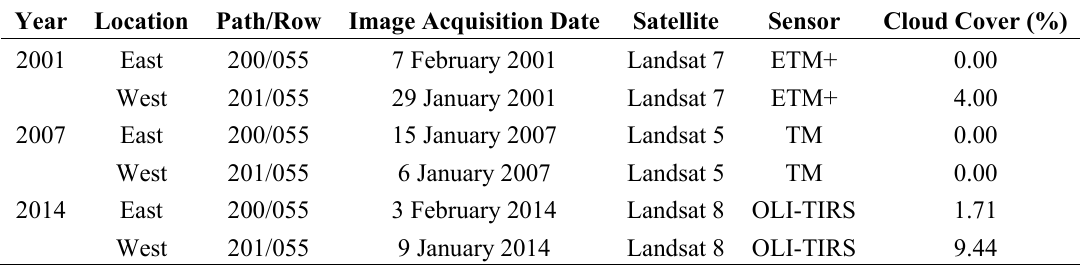
Figure A1. Intermediate products derived from each of CLASlite’s four built-in steps using the 2014 Landsat satellite image over the eastern portion of Gola as an example. ( A ) Band selection for representation of the raw Landsat image is R = Band 5 (0.85–0.88 μ m), G = Band 4 (0.64–0.67 μ m), and B = Band 3 (0.53–0.59 μ m). ( B ) Band selection for representation of the reflectance product is the same as that for (A). ( C ) Band selection for representation of the fractional cover product is R = bare substrate, G = photosynthetic vegetation, B = non-photosynthetic vegetation. ( D ) In forest cover product, grey areas represent forested regions and white areas represent non-forested regions. The Gola National Park boundary is outlined in either red or orange, while the extent of the 25 km boundary surrounding Gola is depicted in blue. Table A1. Supporting information for Landsat satellite images acquired over Gola used in this study. “East” and “West” locations refer to images acquired from the eastern and western portion of Gola. “ETM+” refers to the Enhanced Thematic Mapper Plus sensor, “TM” to the Thematic Mapper sensor, and “OLI-TIRS” to the Operational Land Image-Thermal Infrared